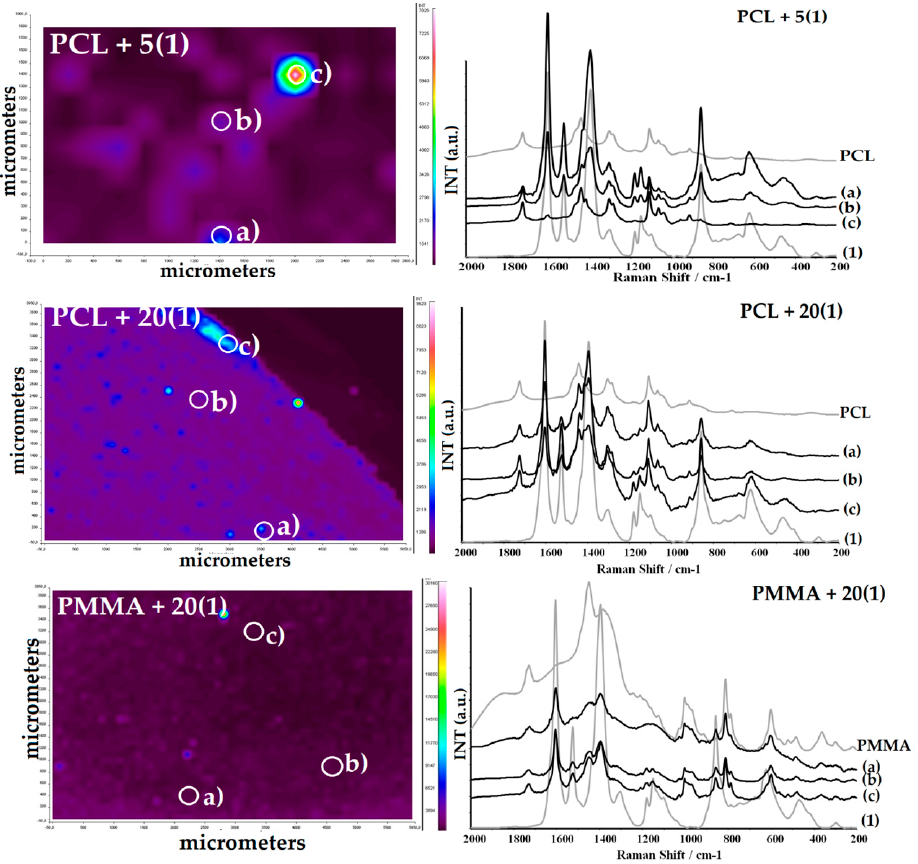
Figure 2. Raman microscopy maps and spectra of PCL + 5( 1 ), PCL + 20( 1 ), and PMMA + 20( 1 ) com- Figure 2. RamanmicroscopymapsandspectraofPCL+5( 1 ), PCL+20( 1 ), andPMMA+20( 1 posites.